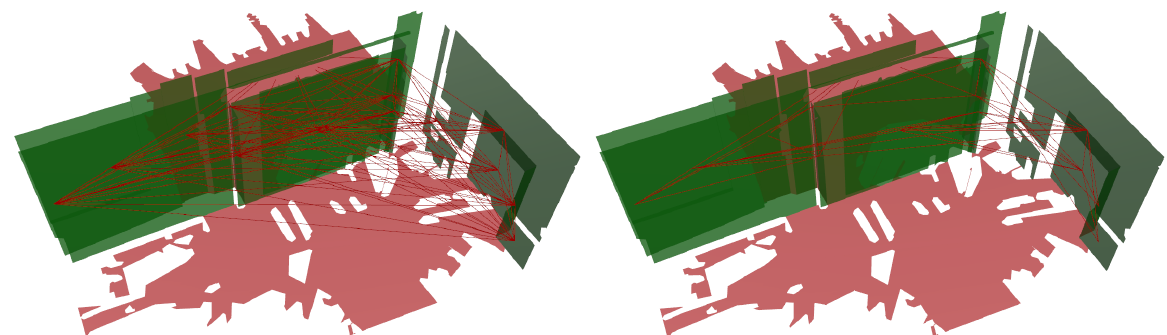
(b) Representation of the potential edges matching one of the three distance criteria.